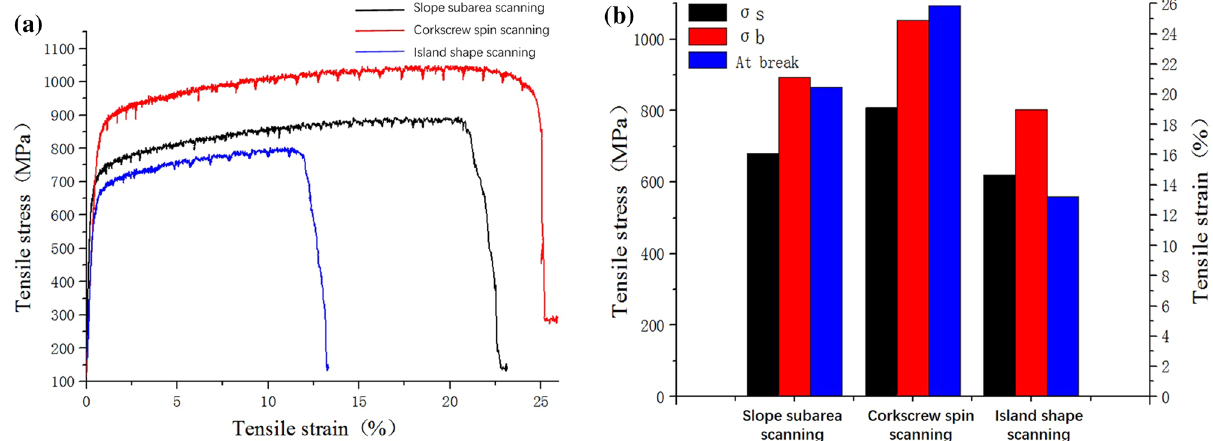
Figure 16. Tensile property of samples under different scanning strategies: ( a ) tensile curve of GH3536 nickel base alloy samples under different scanning strategies; ( b ) histogram of core parameters corresponding to the tensile curve.